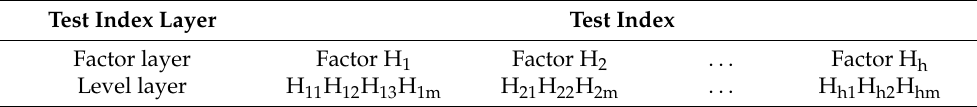
Table 5. The data structure of the orthogonal experiment. Test Index Layer Test Index Factor layer Factor H 1 Factor H